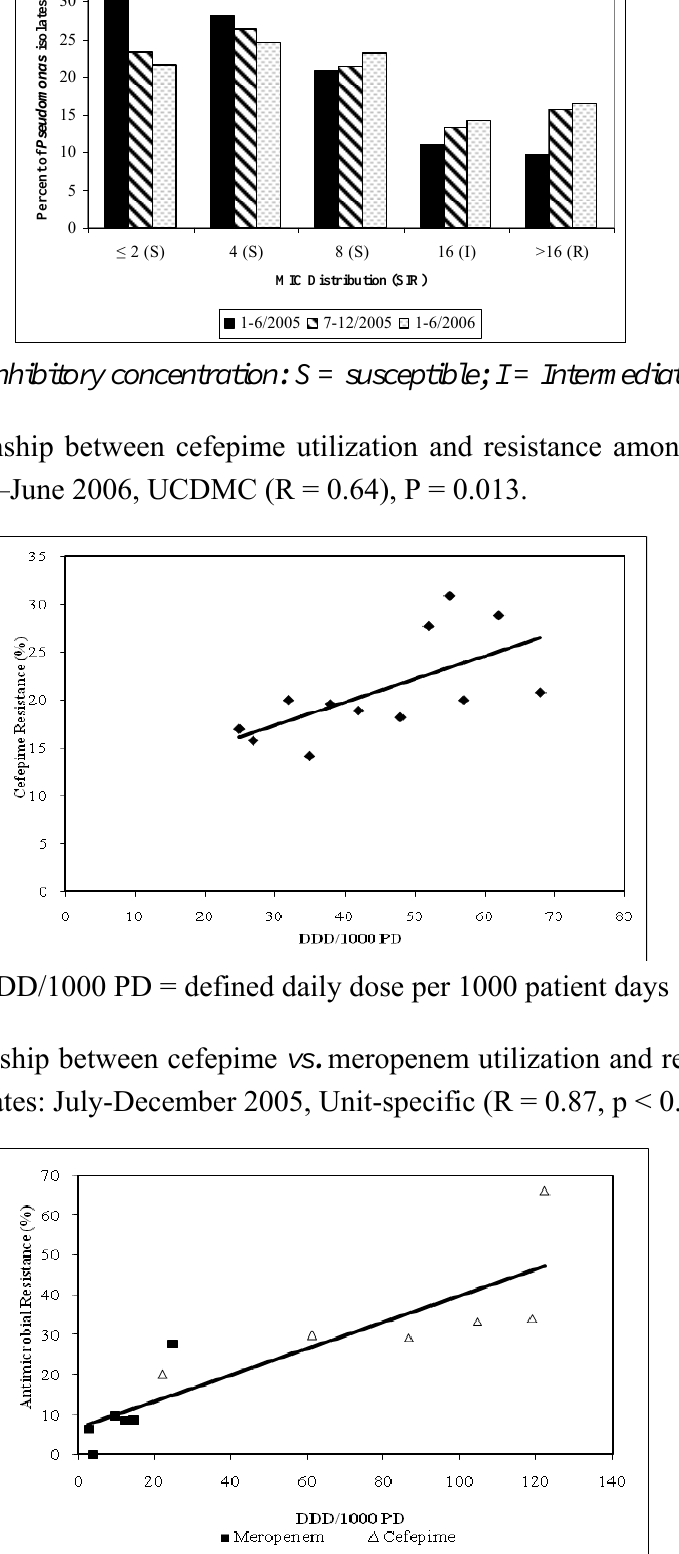
DDD/1000 PD = defined daily dose per 1000 patient